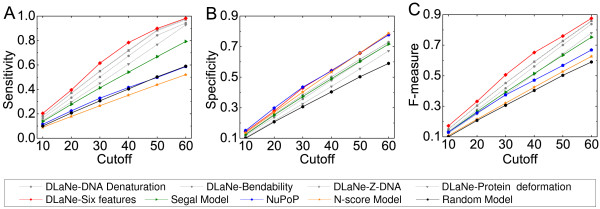
Performance comparisons of the new method DLaNe with three recently methods and the random method with different distance cutoffs. (A) Sensitivity. (B) Specificity. (C) F-measure.